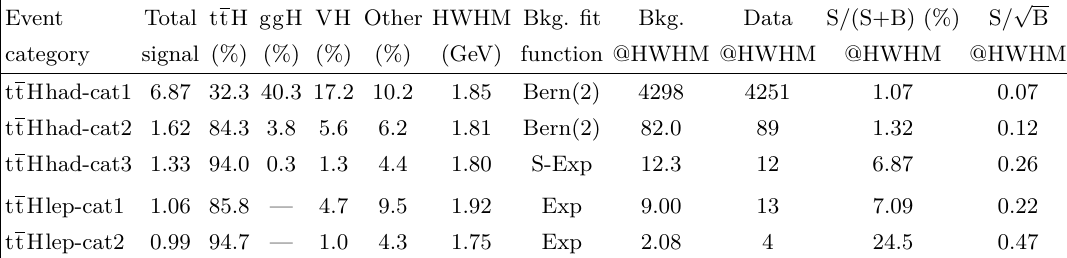
Table 6 . The total expected number of signal events with m the expected contributions from different production modes to the total signal yield (“Other” represents the sum of tH , VBF, and bbH contributions), the HWHM of the signal peak, the functional form used for the background modelling, the estimated number of background events (B) and the observed number of events within ± HWHM , and the S/(S+B) and S / computed within the HWHM of the signal peak, for each of the optimized event categories defined along the ttH hadronic and leptonic BDT